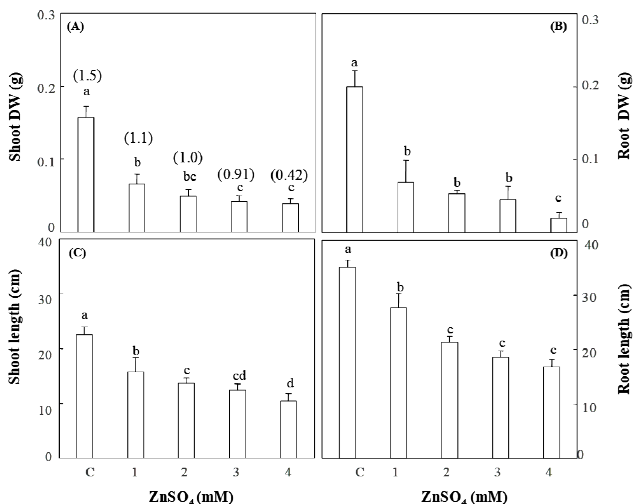
Fig. 1: Shoot (A) and root dry weight (B) and shoot (C) and root length (D) of fenugreek plants grown with different ZnSO 4 concentrations for 52 days. Values on the error bars of A and B correspond to the root:shoot DW ratio, Values (means ± SE of five replicates) fol - lowed by the same letter are not significantly different (Duncan test, P =